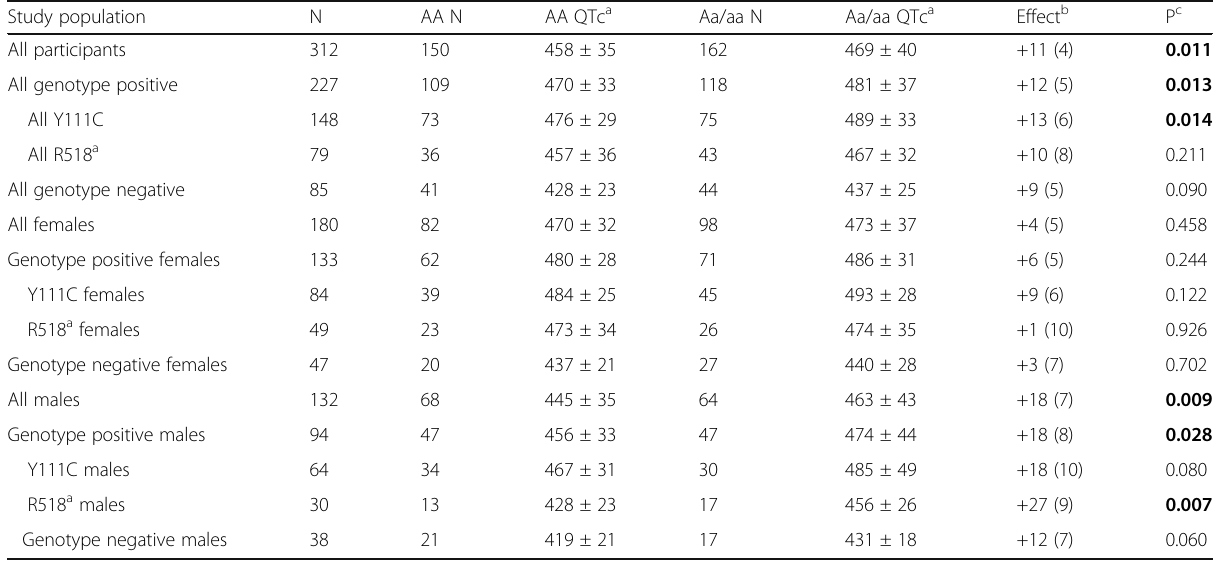
Table 3 Association testing between NOS1AP rs12143842 and QTc, stratified by genotype and sex, in two LQT1 founder